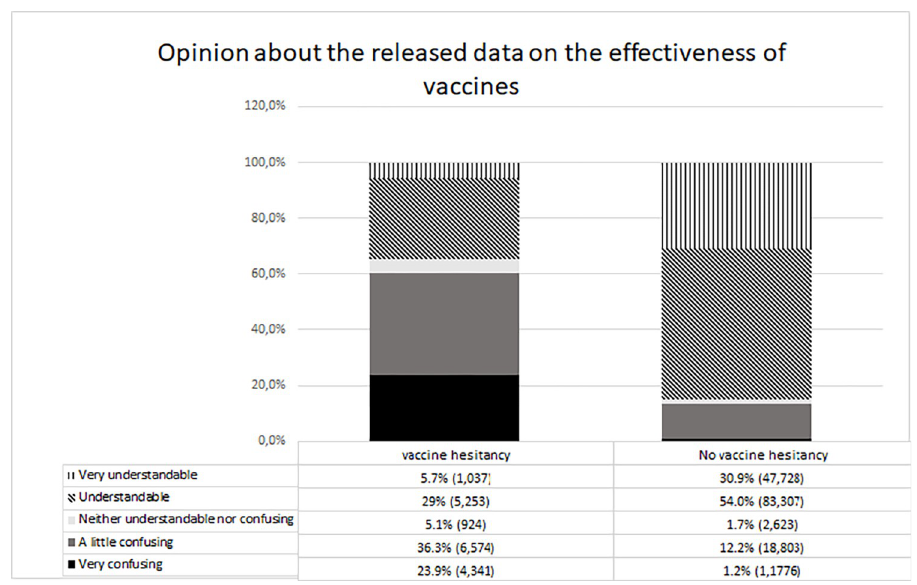
Fig 2. Number of participants who gave their opinion on the understanding of vaccine efficacy data according to vaccine hesitancy. (N = 172,366 respondents, with 154,237 not hesitant and 18,129